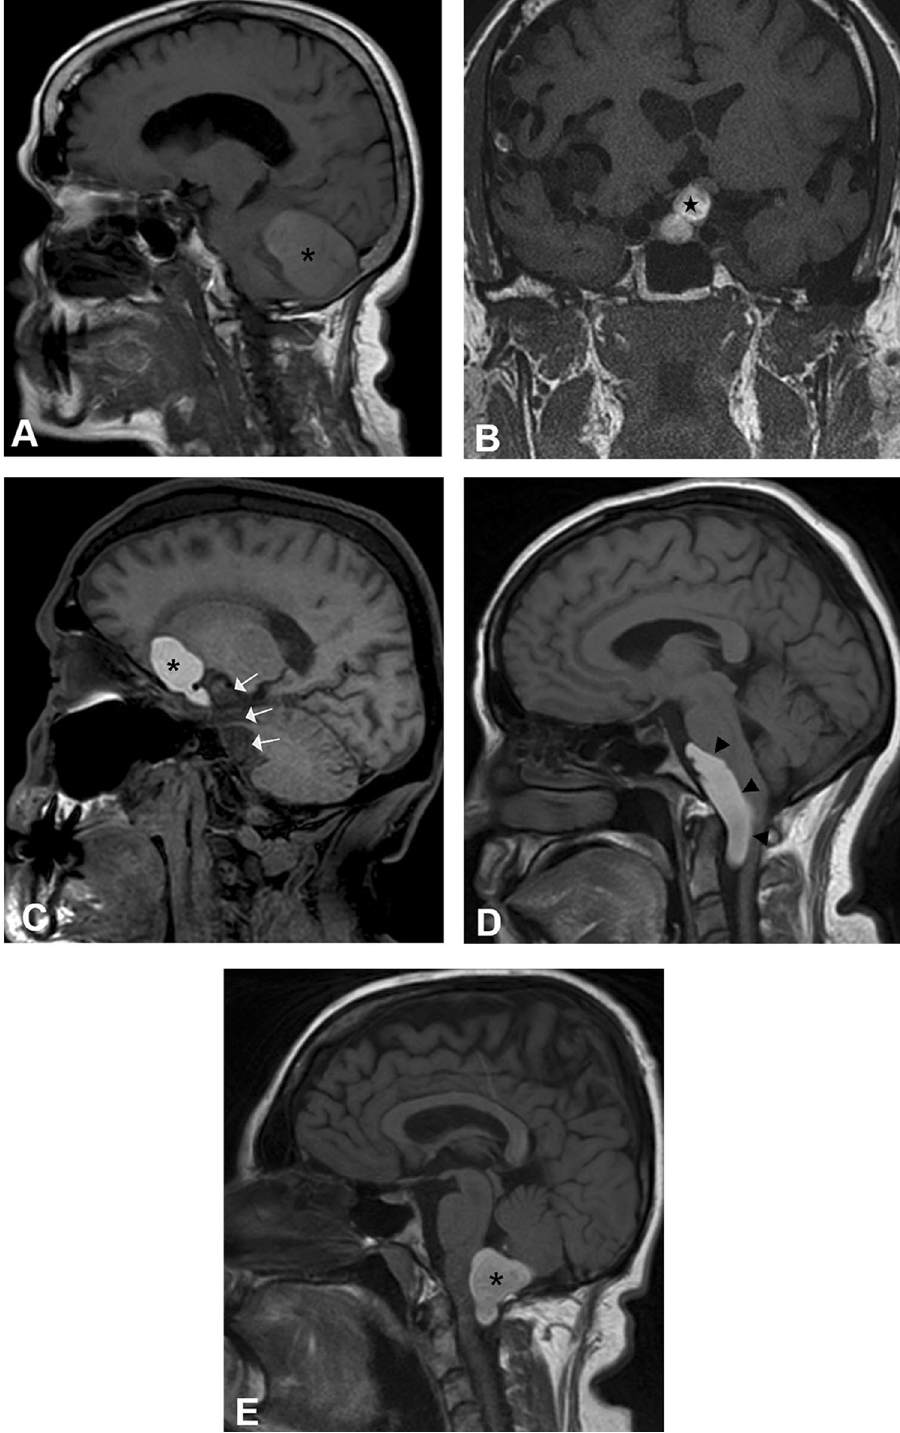
Figure 2. Non-enhanced T1-weighted MR images of the brain demonstrate spontaneously hyperintense white epidermoid cysts. Patients 1, 4 and 5 ( A , D , E ) have lesions in the posterior fossa, with extension to spinal canal in patients 4 (black arrowheads) and 5 (black asterisk). Patient 2 ( B ) presents with a sellar/suprasellar lesion (black star). The lesion in patient 3 ( C ) has 2 components: classic epidermoid posteriorly (white arrows) and white epidermoid anteriorly (black